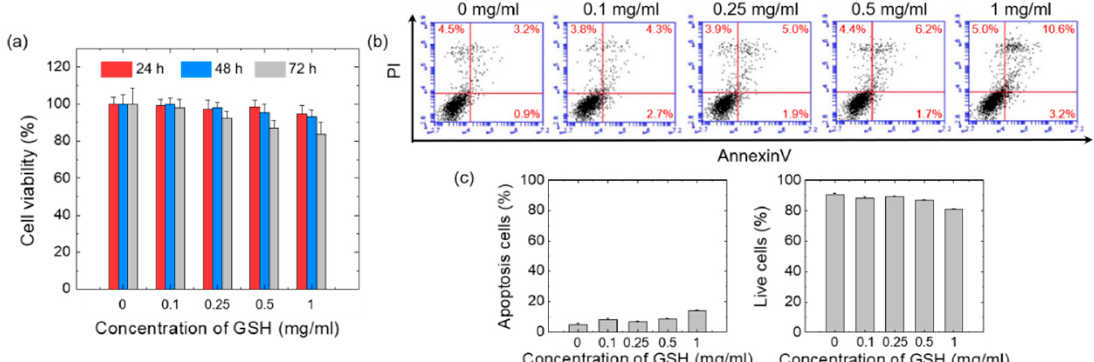
Figure 2. ( a ) MTT assay of GSH -treated HaCaT cells. ( b ) FACS analysis of propidium iodide (PI) uptake and annexin V binding in non-permeabilized cells (lower left, live cells; lower right, early apoptotic cells; upper right, late apoptotic cells, upper left, necrotic cells). The quantification of ( c ) apoptotic cells and live cells from three independent experiments.